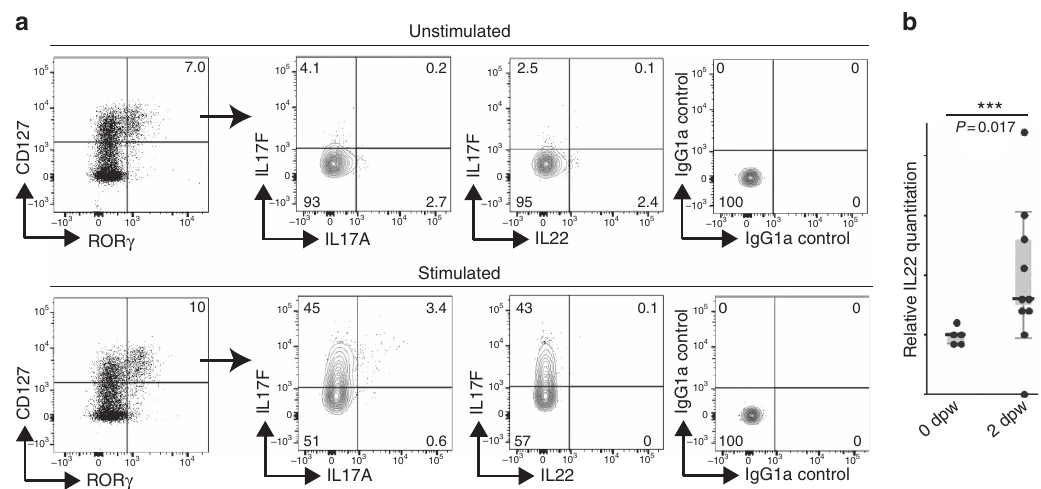
Figure 6 | Wound-recruited ILC3s produce IL17F. ( a ) Cytokine production profile of CD45 þ Lin (cid:3) CD127 þ ROR g þ ILC3s assessed by flow cytometry with intracellular staining. Total skin cells unstimulated or stimulated for 3h in the presence of PMA and ionomycin were analysed. Numbers indicate the percentage of cells in respective quadrants. Analysed cells pooled from eight biological replicates. IgG1a isotype antibodies were included as controls for the intracellular staining. ( b ) mRNA was isolated from unwounded (0 dpw, n ¼ 5) or wounded ROR g þ / (cid:3) ( n ¼ 6) skin collected 2 dpw. Relative mRNA levels of IL22 were quantified by qRT-PCR. mRNA levels were normalized to unwounded controls (designated 1). Data plotted using a quartile, box and whisker plot. Data were not normally distributed and the medians of experimental replicates were analysed by Mann–Whitney test. Wounding induced statistically significant upregulation of IL22 (***, P ¼